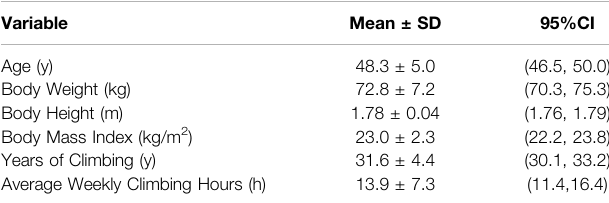
TABLE 1 | Characteristics of the climbers at the 10-year follow-up.